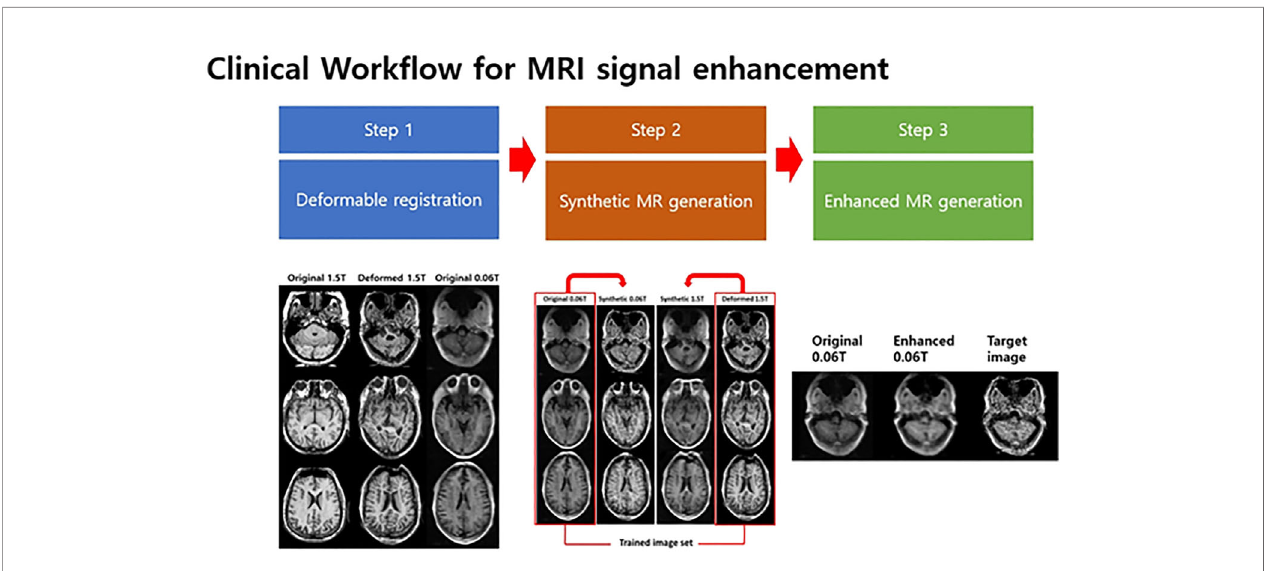
FIGURE 2 | Clinical fl ow for enhancement of unpaired MRI